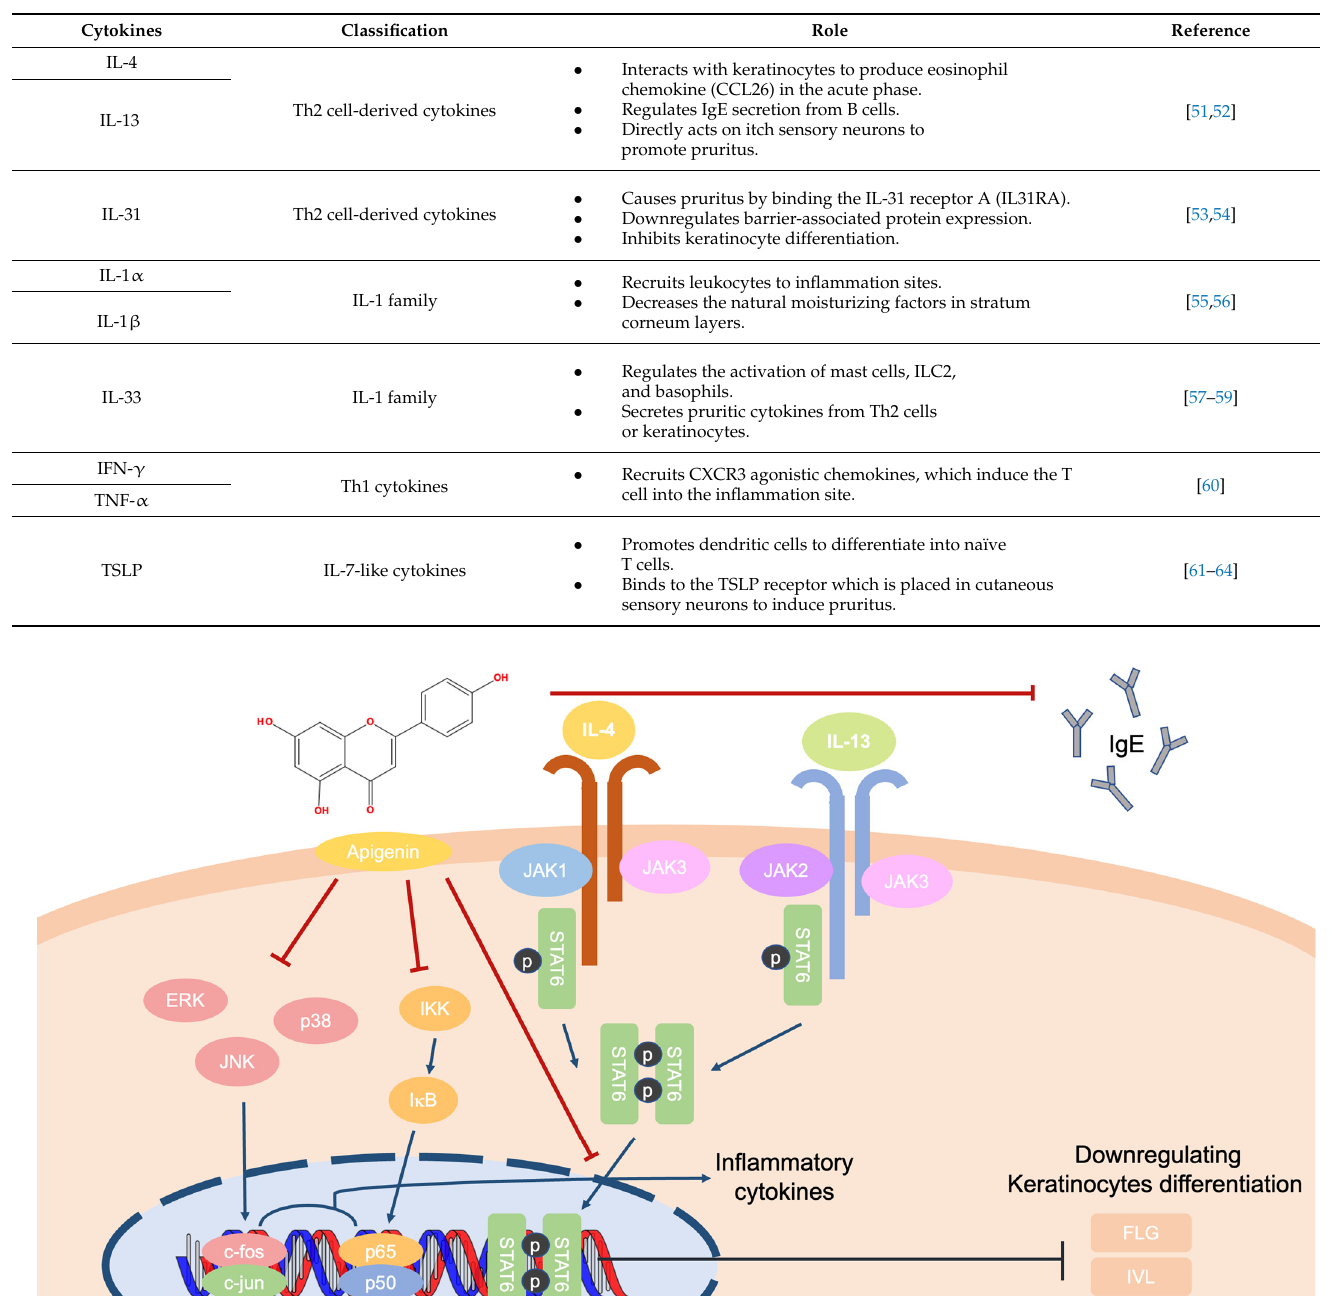
Table 1. The cytokines and chemokines that stimulate AD.